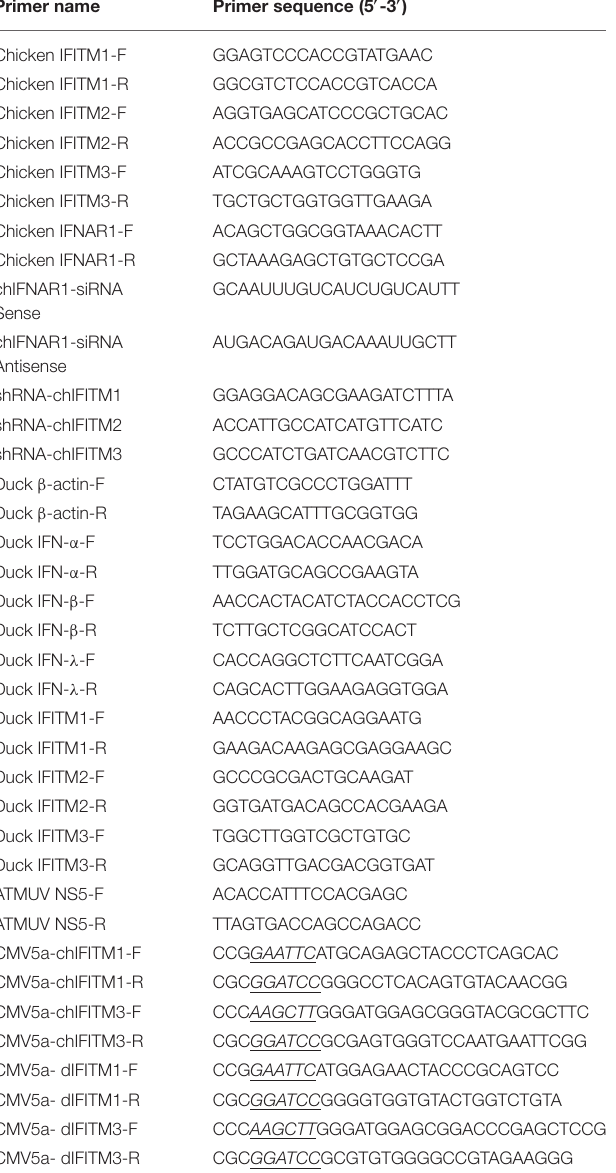
TABLE 1 | Primer sequences used in this